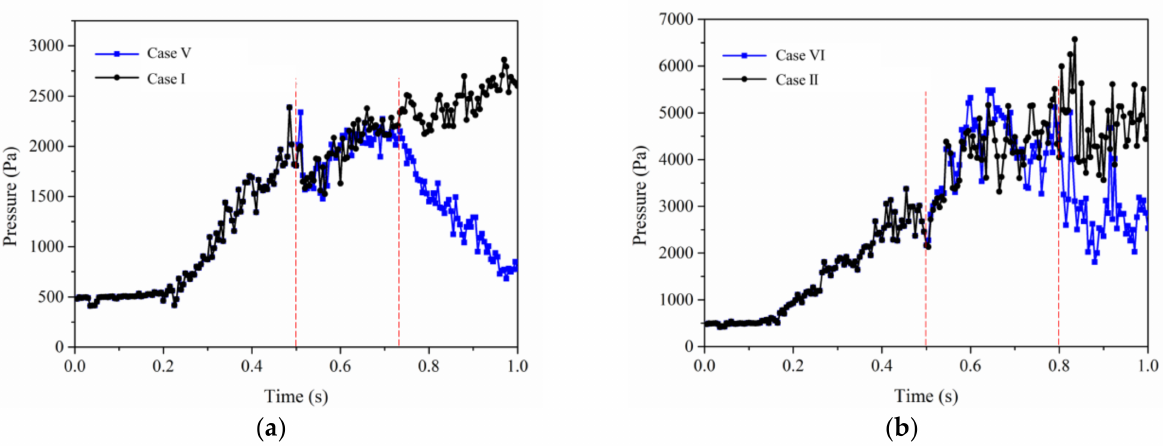
Figure 16. Comparison of inlet–outlet pressure difference variation with time between continuous injection and slug injection: ( a ) small particles, ( b ) large